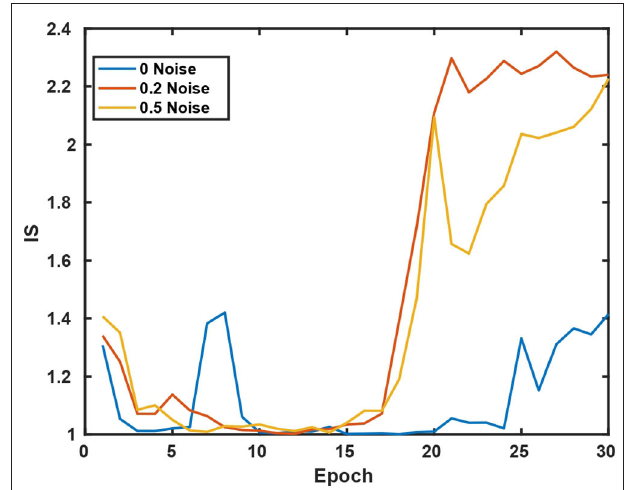
FIGURE 5 | Inception Score w.r.t various standard deviations of